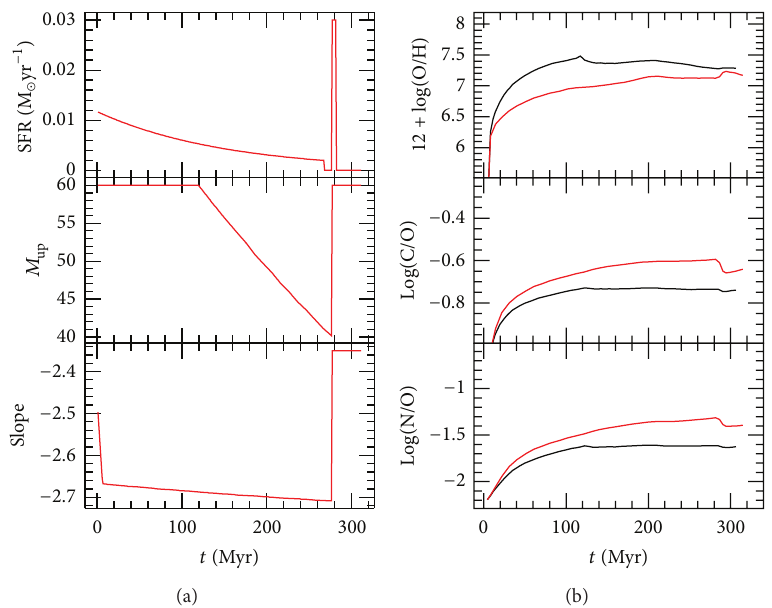
Figure 2: The effect of the IMF on the evolution of galaxies. (a) The adopted SFR (upper panel), together with the upper stellar mass 𝑀 (in M ⨀ , middle panel) and the average slope of the IMF (in number, lower panel) calculated for the IGIMF galactic model (red lines in the right panels). (b) Predicted evolution of abundance and abundance ratios for a IGIMF galactic model (red lines). Plotted are the evolution of oxygen (upper panel), carbon-to-oxygen ratio (middle panel), and nitrogen-to-oxygen ratio (lower panel). The black line represents the evolution of a model with a time-independent Salpeter IMF (i.e., with a slope of − 2.35).